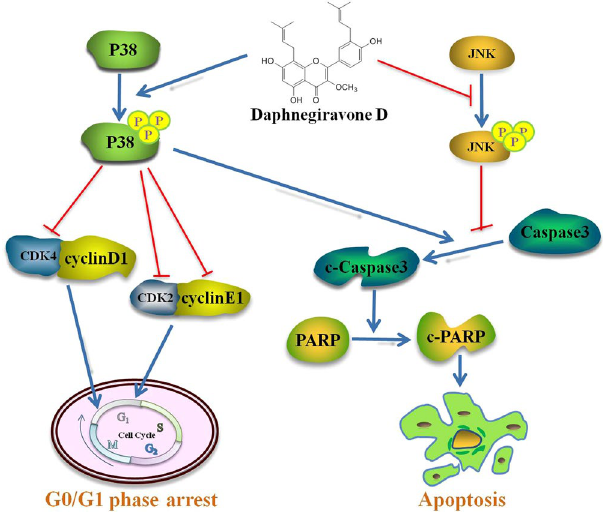
Figure 9. Schematic form of the proposed mechanisms of G0/G1 arrest and apoptosis induced by daphnegiravone D on hepatoma cells. Daphnegiravone D promoted the phosphorylation of p38/MAPK, down- regulation the expression of cyclin E1, CDK 2 and CDK4, induced G0/G1 arrest in Hep3B and HepG2 cells. Besides, p38/MAPK could promote apoptosis via accelerating the cleavage of caspase 3 in